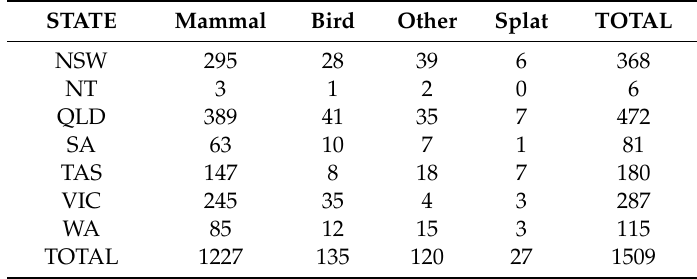
Table 1. Total number of reports by state between 24 / 9 / 2019 and 5 / 12 / 2019 UTC.